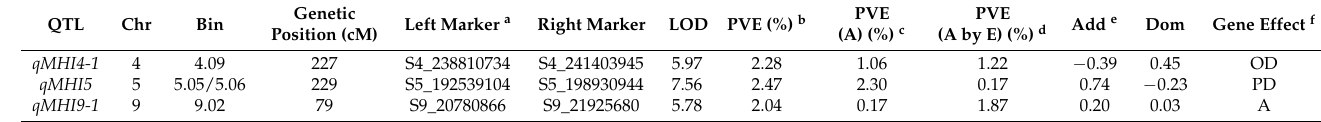
Table 5. QTL by environment interaction analysis of maternal inducibility in the F 2 population.